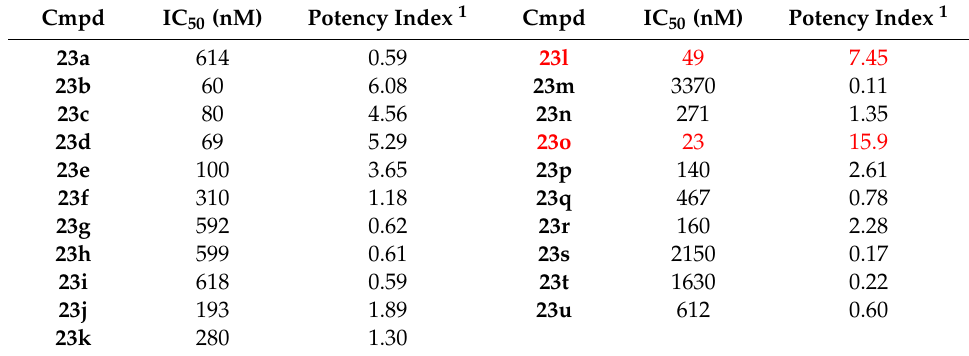
Table 3. Inhibition of Ee AChE by pyrazolophthalazine tacrines 23a – u (data from